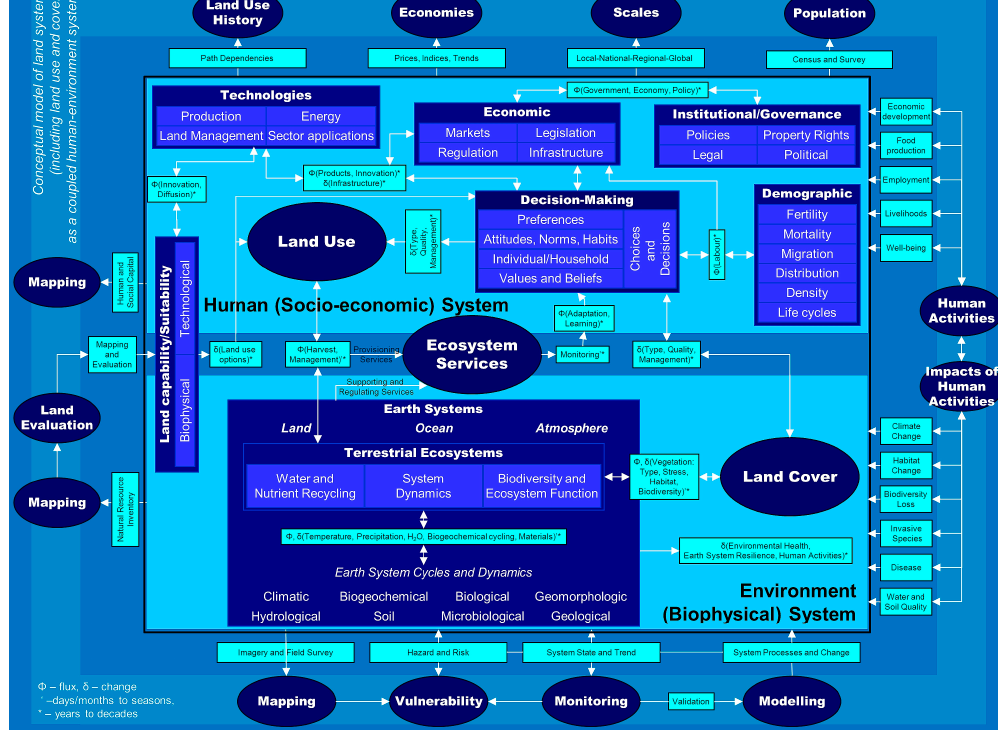
Figure 1. Conceptual model of land system as a coupled human–environment system.